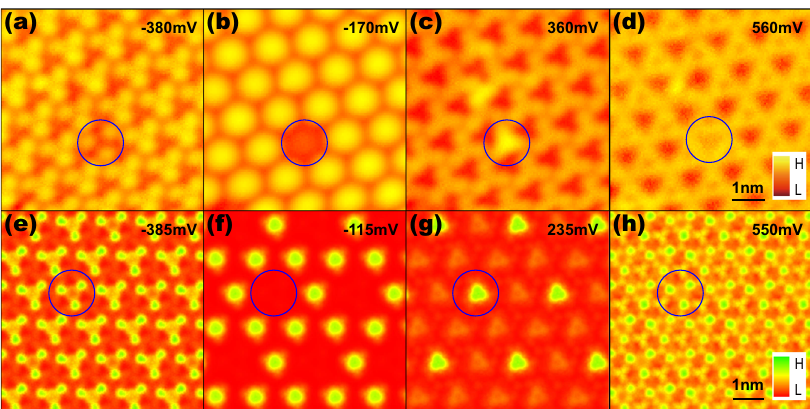
Fig. 3 Orbital textures around a symmetric Ti-doped SD at different energies. a – d Experimental dI / dV maps at − 380, − 170, 360, and 560 mV. The Ti-doped SD shows a dim (bright) intensity below (above) the Fermi level. The sample shows a three-fold symmetry in other three dI / dV maps. e – h First-principle partial charge within a 35 meV energy window centered at four characteristic energies. The small difference between experimental and theoretical energies are chosen to clearly present the prominent